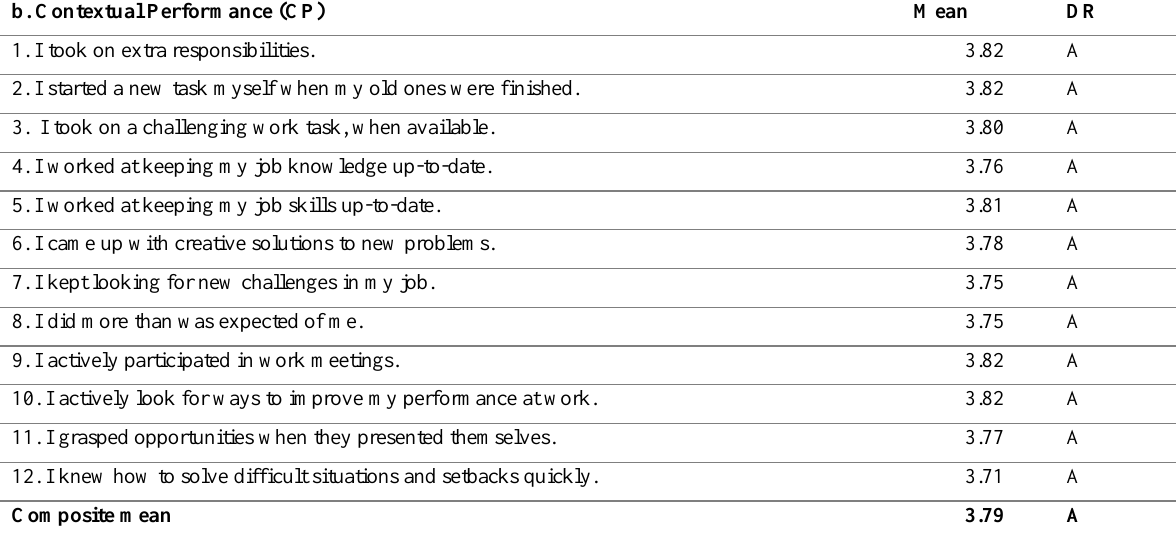
Table 4: Individual Work Performance as to Contextual Performance